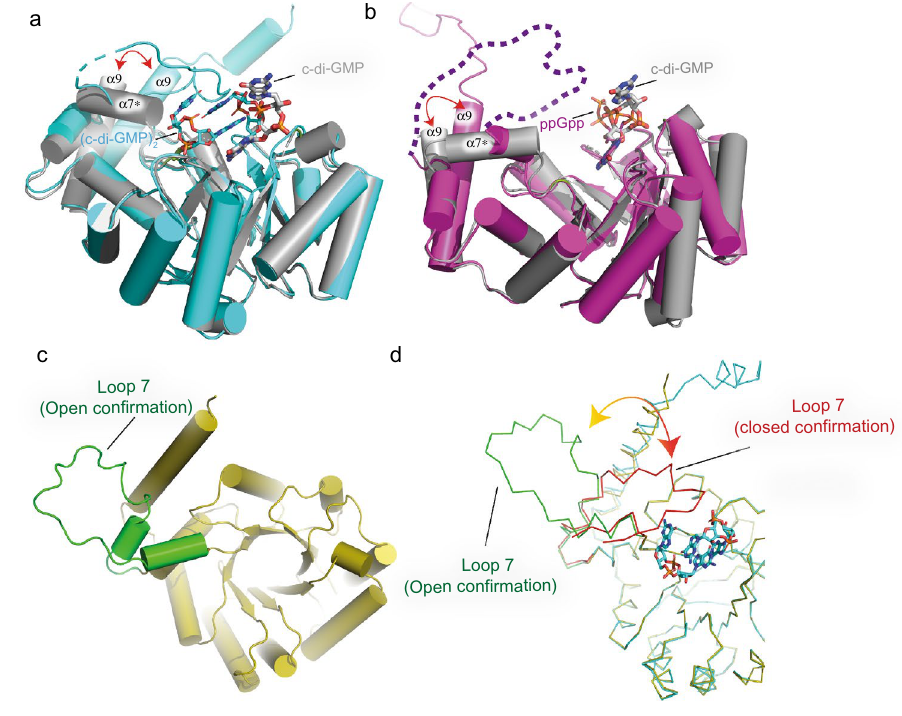
Figure 5. Structural comparison of SmbA Δloop /c-di-GMP with SmbA wt /(c-di-GMP) 2 , SmbA wt /ppGpp and Alphafold model of SmbA wt . ( a ) Superposition of SmbA Δloop /c-di-GMP (gray) with SmbA wt /(c-di-GMP) 2 (cyan) with RMSD of 0.4. Relevant secondary structure elements are labeled. Dimeric c-di-GMP (cyan) and monomeric (thick) are shown as ball-and-stick models. ( b ) Superposition of SmbA Δloop /c-di-GMP (gray) with SmbA/ppGpp (Magenta) with RMSD of 0.5. Relevant secondary-structure elements are labeled. ppGpp (magenta) and monomeric (thick in gray) are shown as ball-and-stick models. The disordered part of loop 7 is marked by broken lines. ( c ) AlphaFold2 predicted model of SmbA wt (yellow) with loop 7 is show in green color. ( d ) Superposition of SmbA wt /(c-di-GMP) 2 (green) with AlphaFold2 model of SmbA wt (yellow). Loop 7 from SmbA wt /(c-di-GMP) 2 and Alphfold model of SmbA wt apo are show in red and green